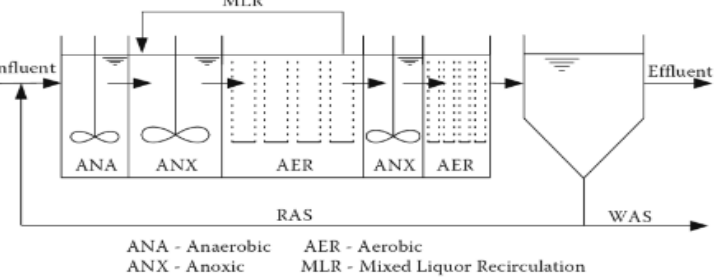
Figure 2. Common process configuration for a bioreactor for biological nutrient removal [7].